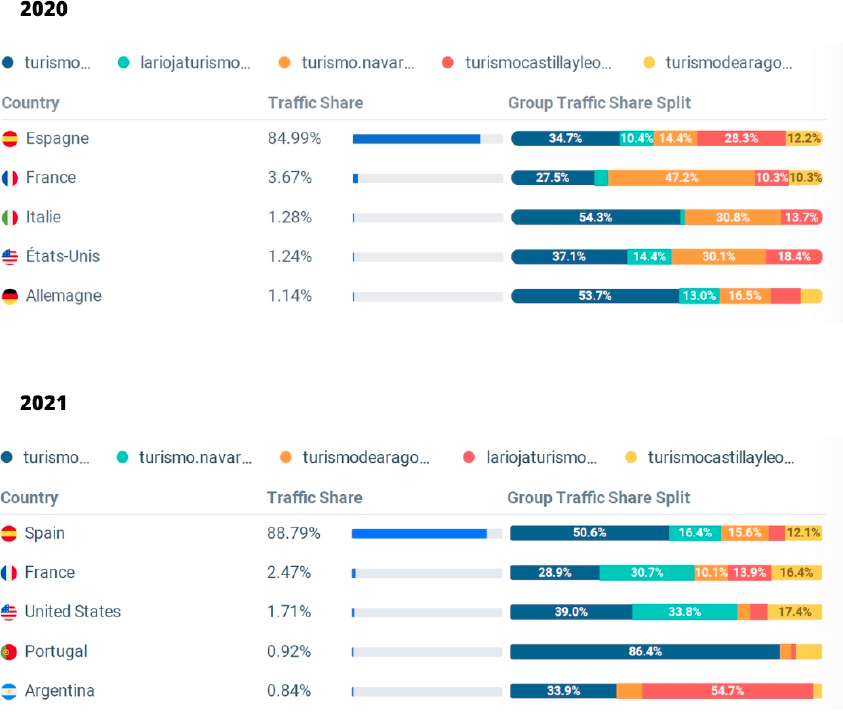
Figure 7. Origin of users of the sites of the ACs analyzed 2020–2021 .